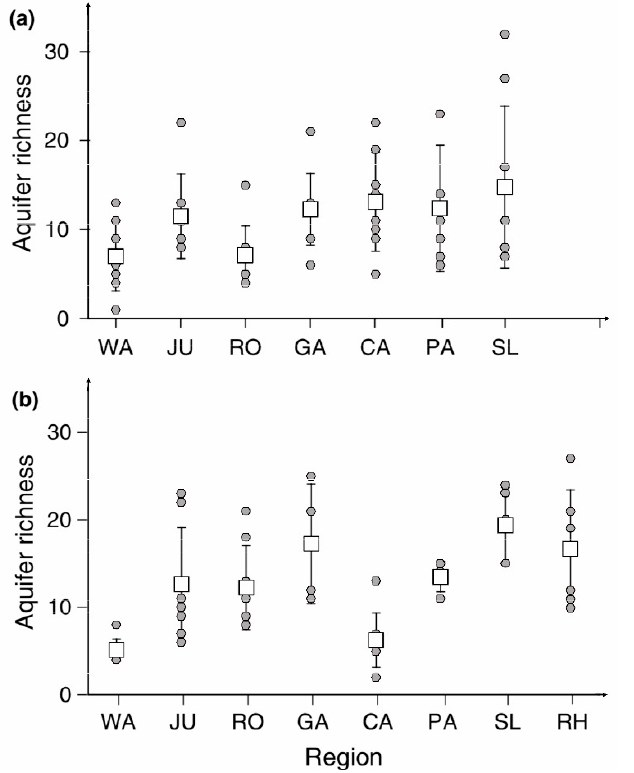
Figure 9. Differences in species richness (+SD) for porous aquifers from Wallonia (WA), Jura (JU), Roussilon (RO), Cantabria (CA), Padano–Alpine region (PA), Slovenia (SL), Rhône River valley (RH) and Garonne (GA) regions. ( a )—karst, ( b )—interstitial. From Malard et al. [58], modified.